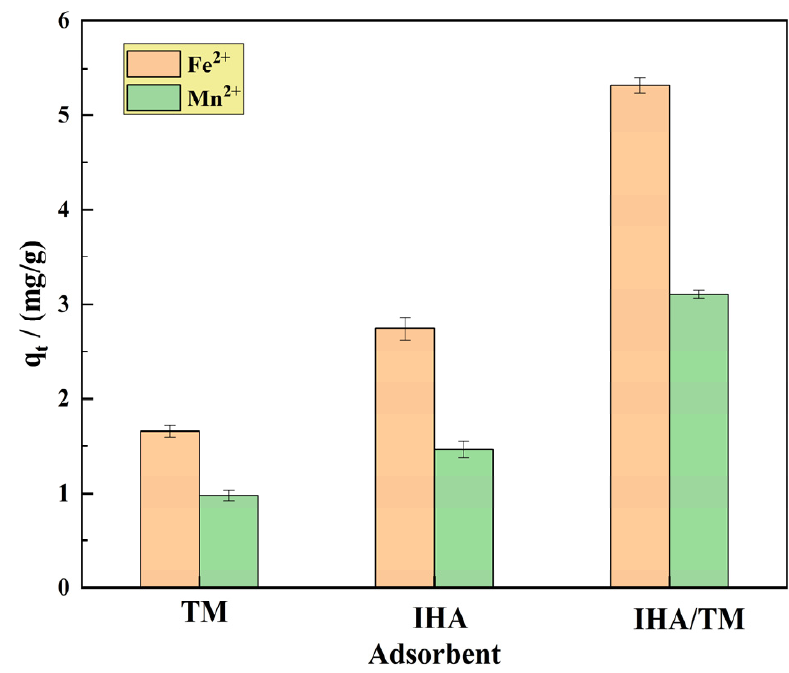
Figure 4. The effects of different materials on the adsorption of Fe 2+ and Mn 2+ .